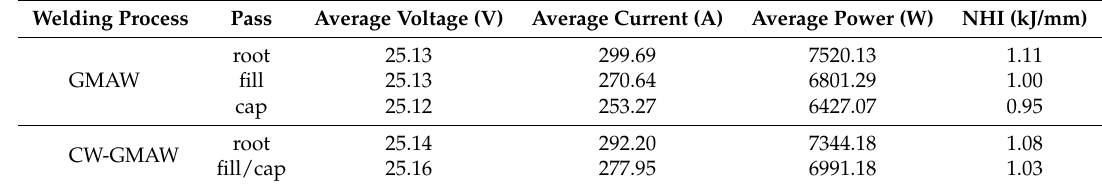
Table 3. Average electrical parameters sampled during welding and nominal resulting heat input as response of the welding power